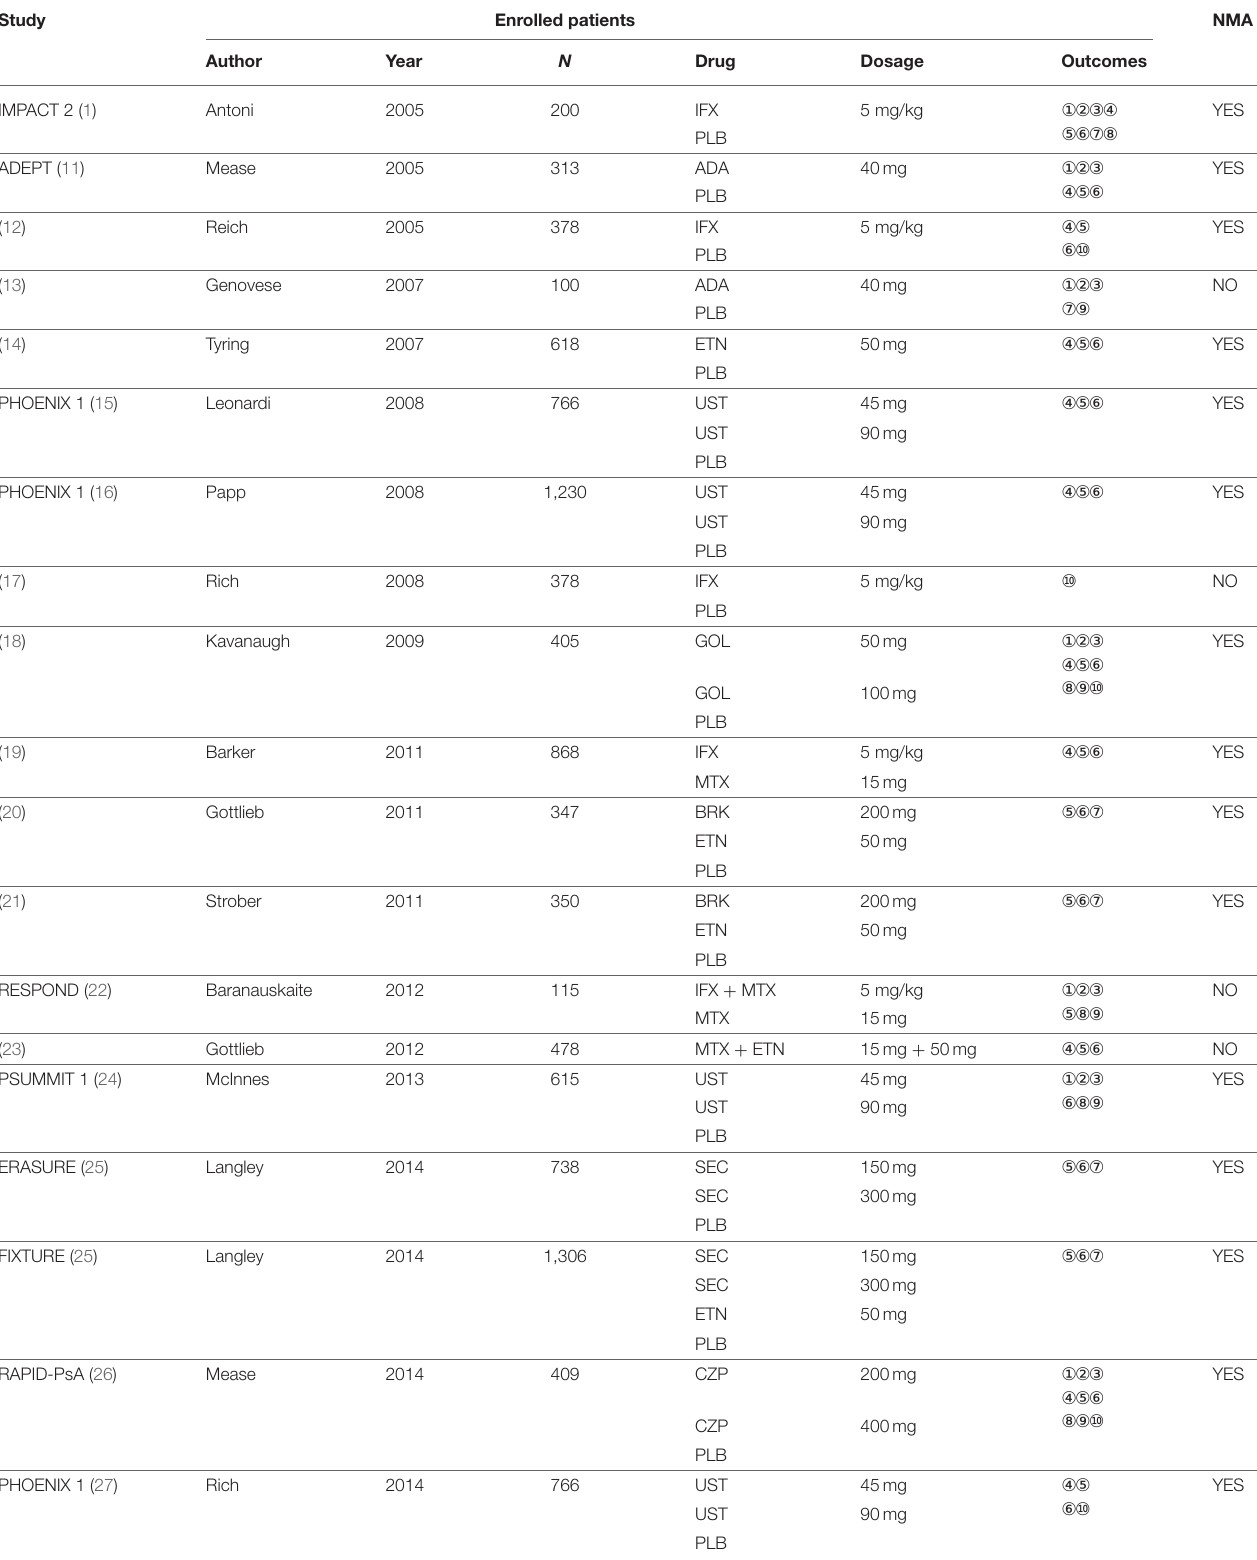
TABLE 1 | RCT included in the systematic review and NMA, focusing on the outcomes of GRAPPA domains.